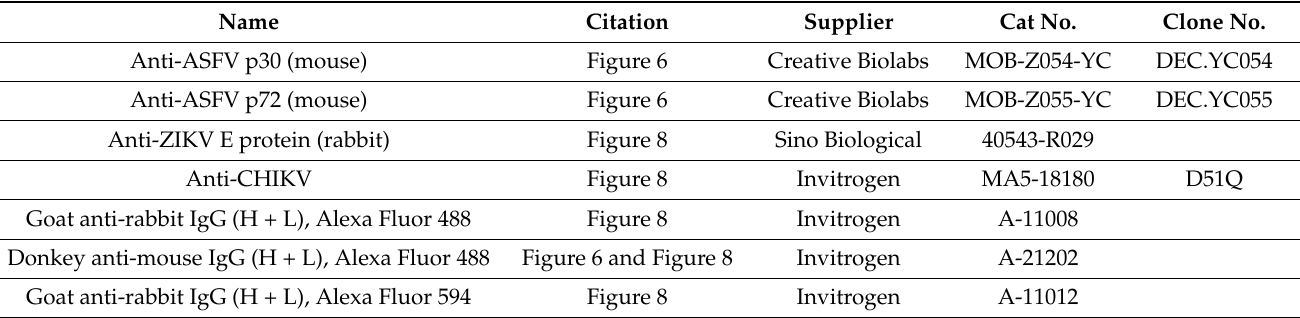
Table 1. Antibodies used for immunofluorescence assay